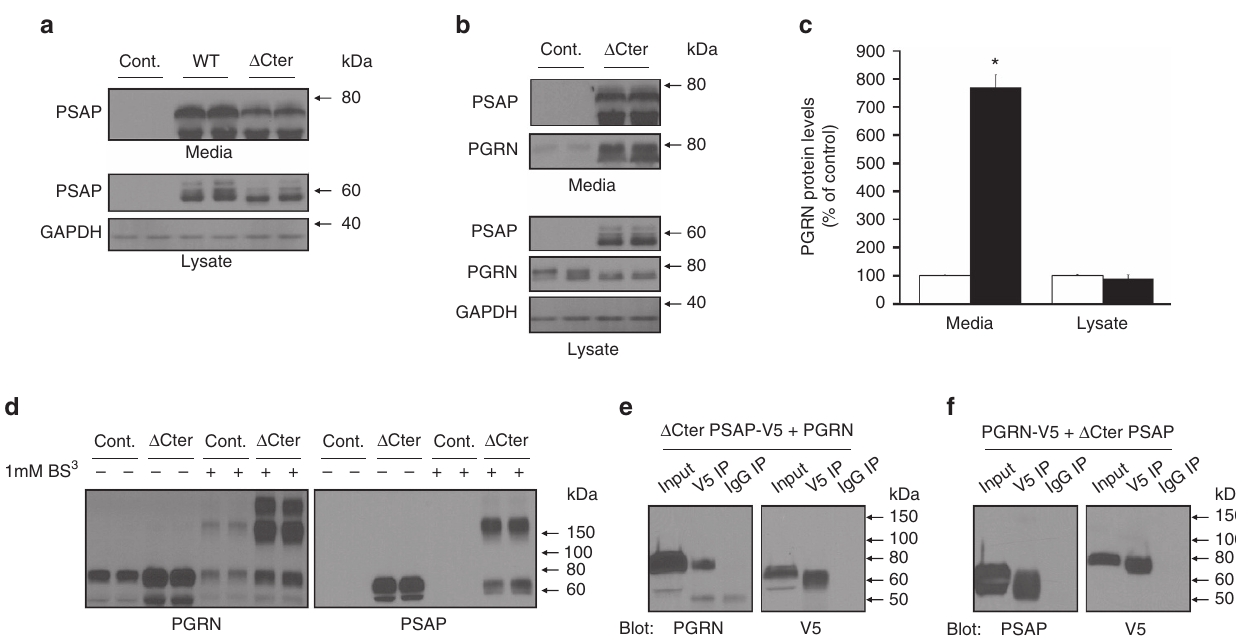
Figure 10 | D Cter PSAP does not affect PSAP-induced changes in PGRN levels or oligomerization. ( a ) Immunoblots of lysates and conditioned media harvested from HeLa cells transfected with either a control (Cont.) plasmid or with wild-type (WT) or D Cter PSAP plasmids. ( b ) Immunoblots of lysates and conditioned media harvested from HeLa cells transfected with either a control or D Cter PSAP plasmid. ( c ) Quantification of media and lysate PGRN levels from HeLa cells transfected as described in ( b ) ( n Z 12 per group). ( d ) Immunoblot of media from HeLa cells transfected with either a control or D Cter PSAP plasmid that had been treated with ( þ ) or without ( (cid:3) ) 1mM BS 3 . ( e , f ) Co-IP assays of conditioned media harvested from HeLa cells co-transfected with D Cter PSAP-V5 and untagged PGRN plasmids ( e ) or with PGRN-V5 and untagged D Cter PSAP plasmids ( f ). *Differs from control-transfected cells, P o 0.0001 by Student’s t